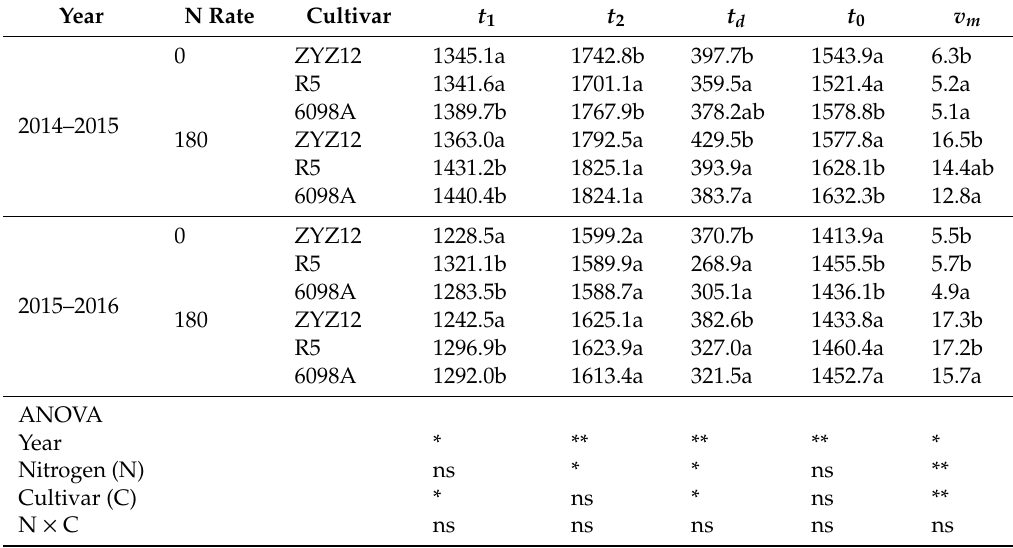
Table 2. Biomass dynamic parameters of the oilseed rape cultivars grown at two N rates during the experimental seasons. Values with di ff erent letters are significantly di ff erent at a probability level of p < 0.05 within each N rate in the same season. t 1 and t 2 , the initial and terminal points of the rapid growth period; t d , the duration of the rapid growth period; t 0 , the point at which the maximum growth rate occurs and V m , the maximum growth rate. *, p < 0.05; **, p <